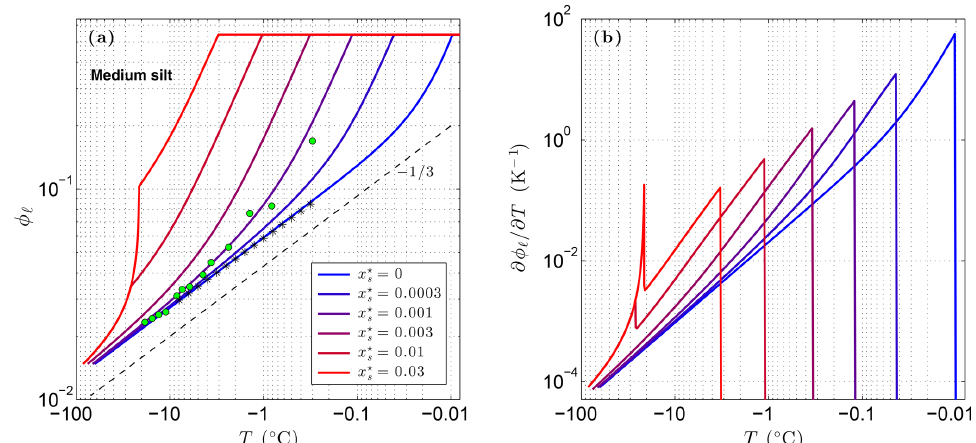
Figure 3. Volume fraction of liquid water φ (cid:96) predicted for a medium-grained silt ( r = 15µm) with NaCl solute concentrations x (cid:63) s ranging 0 to 0.03 (a) . The depth z ≈ 0m, φ = 0 . 54, and λ = 0 . 36µmK 1 / 3 . Green dots show measured φ (cid:96) values for Fairbanks silt ( φ = 0 . 54) reported by Yuanlin and Carbee (1987). Stars correspond to the empirical equation fitting unfrozen water measurements in Fairbanks silt given by Anderson et al. (1973). Panel (b) shows the sensitivity of the liquid water content to temperature, ∂φ (cid:96) /∂T .